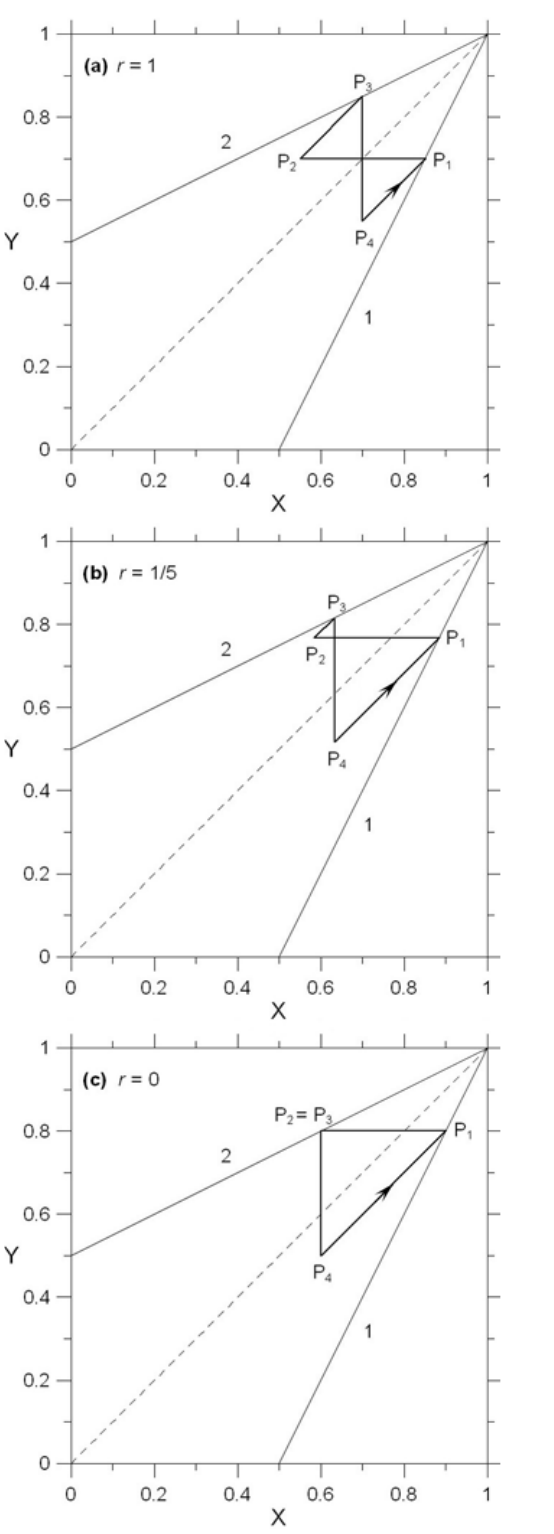
Fig. 2. Three possible limit cycles of the system, for different values of the ratio r ( α = 1, (cid:15) = 0 . 7).